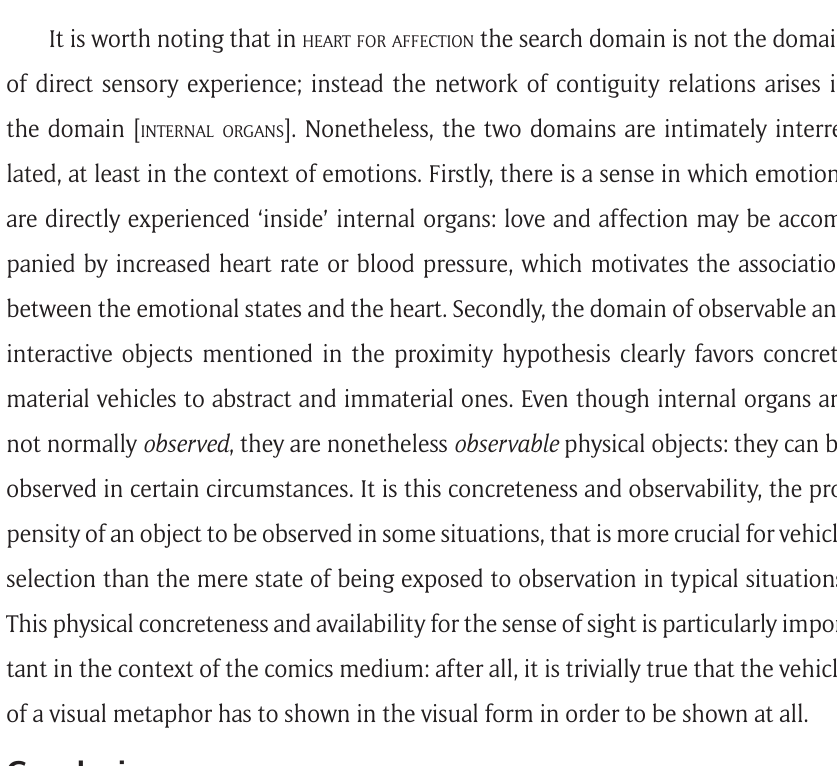
Figure 7: Contiguity relations in heart for affection (author’s own